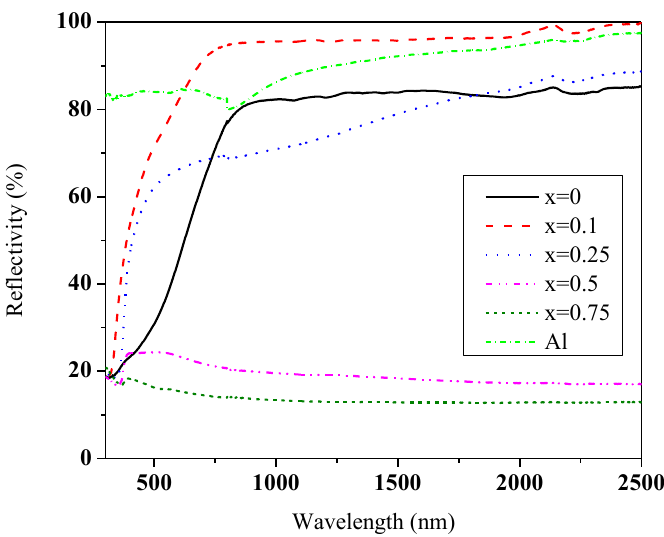
Sr TiO 1− x x 3+δ